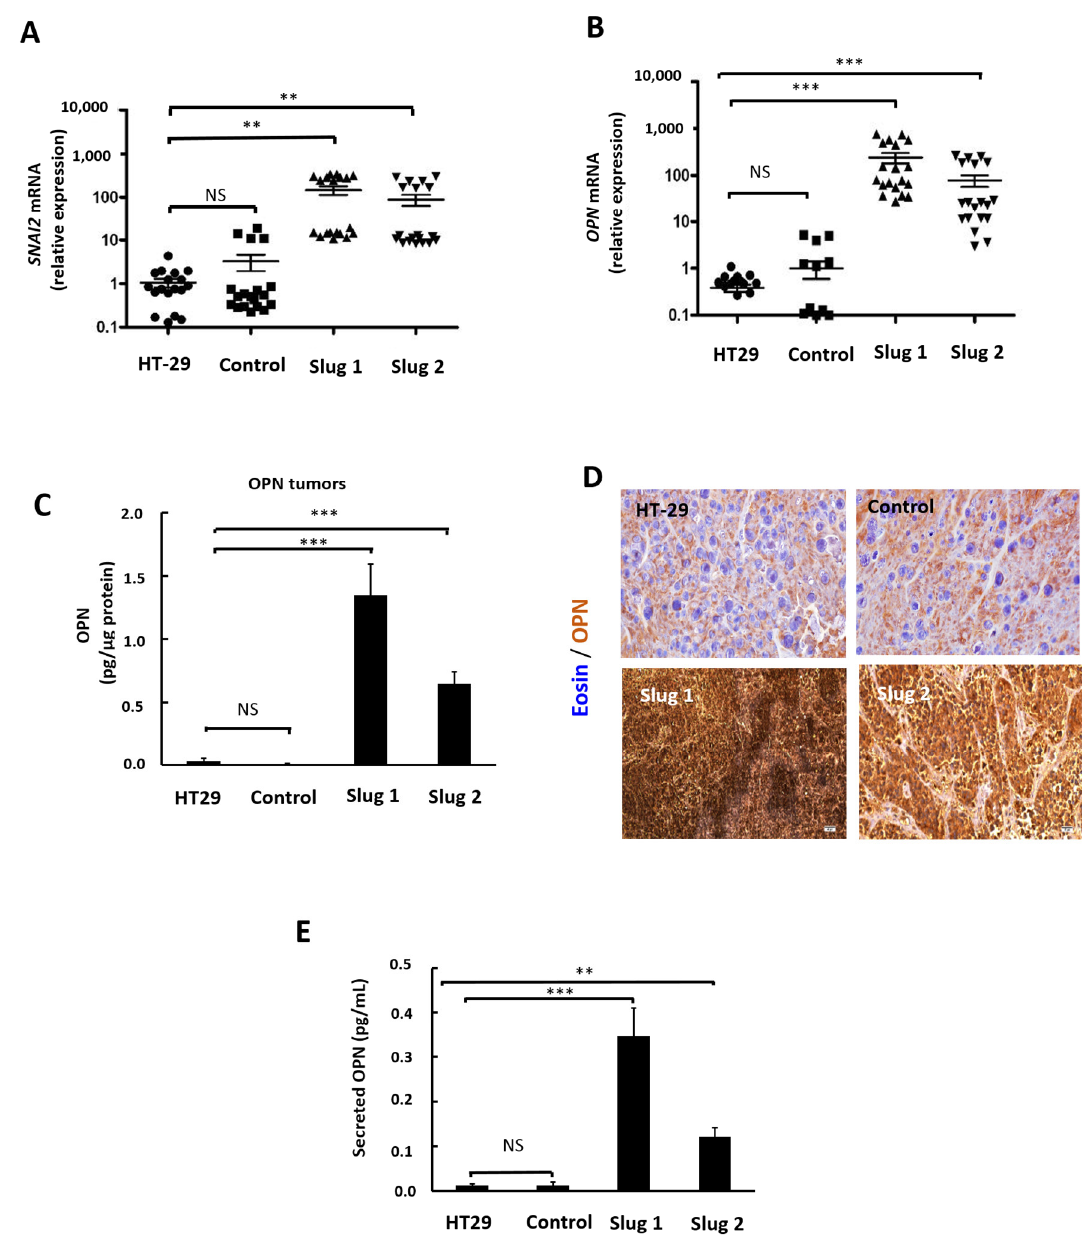
Figure 7. Influence of Slug on OPN expression in tumor xenografts. Tumor xenografts were estab- lished in nude mice from HT-29, control, Slug1, and Slug2 cells. Four weeks after injection, tumor xenografts and blood were collected for further analysis. ( A , B ) mRNA was extracted from the tumor xenografts, and the expression of mRNA for Slug ( A ) and OPN ( B ) was determined by qRT-PCR using human primers. The data represent a total of 76 different tumor samples. ( C ) The levels of tumor-associated OPN protein were determined by ELISA analysis. ( D ) Immunohistochemistry of OPN. A strong brown coloration indicates the presence of osteopontin. Nuclei were stained with eosin (blue). ( E ) Serum levels of OPN were quantified by ELISA analysis. The values represent the average of two independent experiments carried out for three mice in each groups in triplicate. Data were analyzed by the Student’s two-tailed t -test and considered significant when p was less than 0.05. Symbols: ** p < 0.01; *** p < 0.001, NS, not significant.